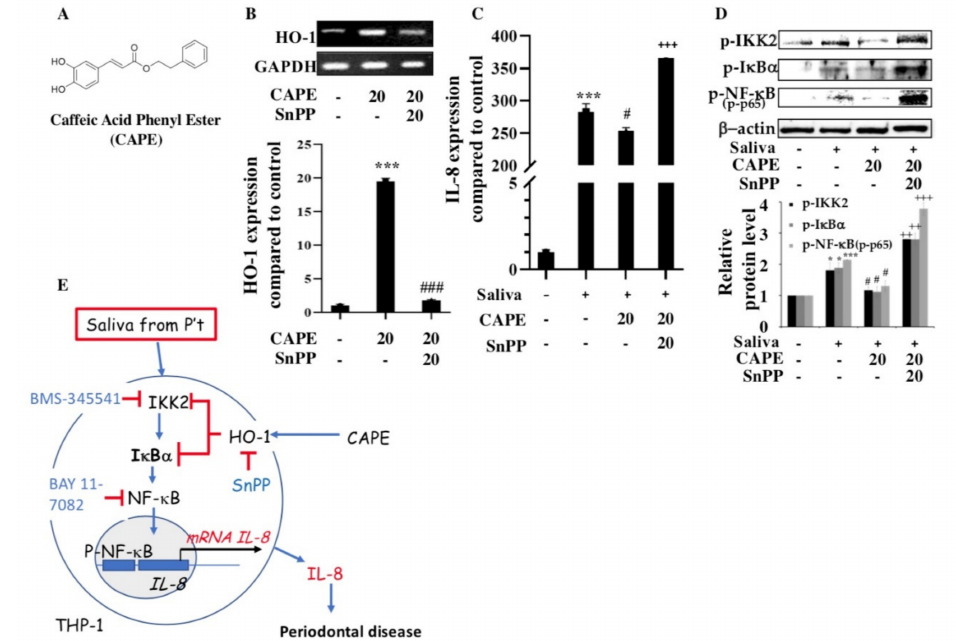
Figure 4. The effects of caffeic acid phenethyl ester (CAPE) on saliva-induced interleukin-8 (IL-8) expression in THP-1 cells and potential underlying molecular mechanisms. ( A ) Structure of CAPE. ( B ) Effects of CAPE (20 µ M) and tin-protoporphyrin (SnPP, heme oxygenase-1 (HO-1) inhibitor; 20 µ M) on HO-1 mRNA and protein expression in THP-1 cells. Data represent the mean ± standard error of the mean (SEM; n = 3). *** p < 0.001 compared to control group; ### p < 0.01 compared to CAPE-treated group (Student’s t -test). ( C ) Effects of CAPE and SnPP on saliva-induced IL-8 mRNA expression in THP-1 cells. ( D ) Levels of phosphorylated IKK2, I κ B α , and NF- κ B (p65) proteins in THP-1 cells stimulated with 5% saliva alone or pretreated with 20 µ M CAPE or CAPE combined with SnPP before saliva treatment. Data represent the mean ± SEM ( n = 3). * p < 0.05, *** p < 0.001 compared to control group; # p <0.05 compared to saliva-treated group; ++ p < 0.01, +++ p < 0.001 compared to CAPE-treated group (Student’s t -test). ( E ) Working model for saliva-induced IL-8 expression via the IKK2/I κ B α /NF- κ B pathway in periodontal disease. Blue arrow = stimulation; red line with an end bar = inhibition; black arrow = direction or